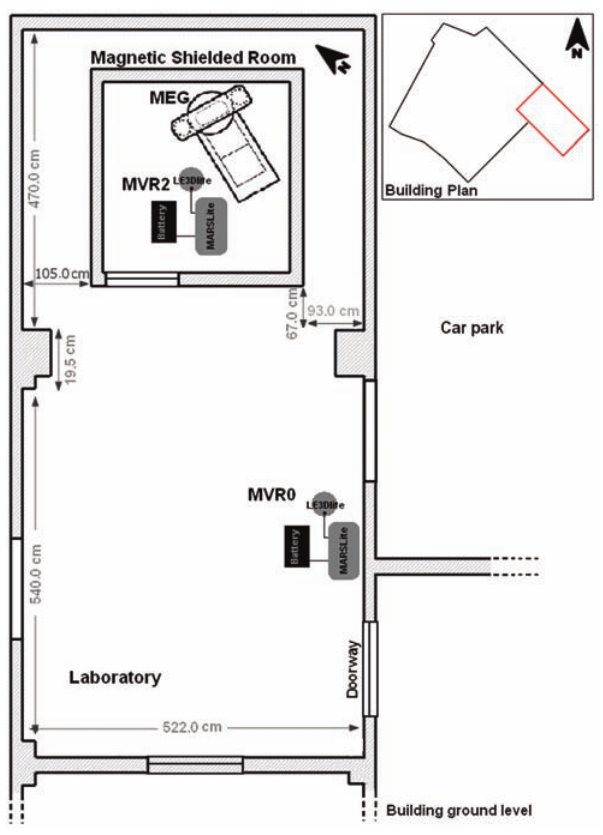
Figure 1. Top right: Building plan of the south-eastern sector of the Villa Russo Hospital complex (Naples, Italy), where the MEG system is hosted. Red line, the two rooms where the MEG system and the two seismic stations, MVR0 and MVR2, are installed. Left: Plan of these two rooms. Top room: The MSR setting, with station MVR2 at the centre, with the MEG system at the top right. This is composed of a couch where a patient lies, a fibreglass dewar with a helmet-shaped bottom, the SQUID sensor array housed around the helmet, and a mechanical support that places the helmet over the had of the patient. Bottom room: The laboratory where the magnetometric data are analyzed, with the location of station MVR0 shown.